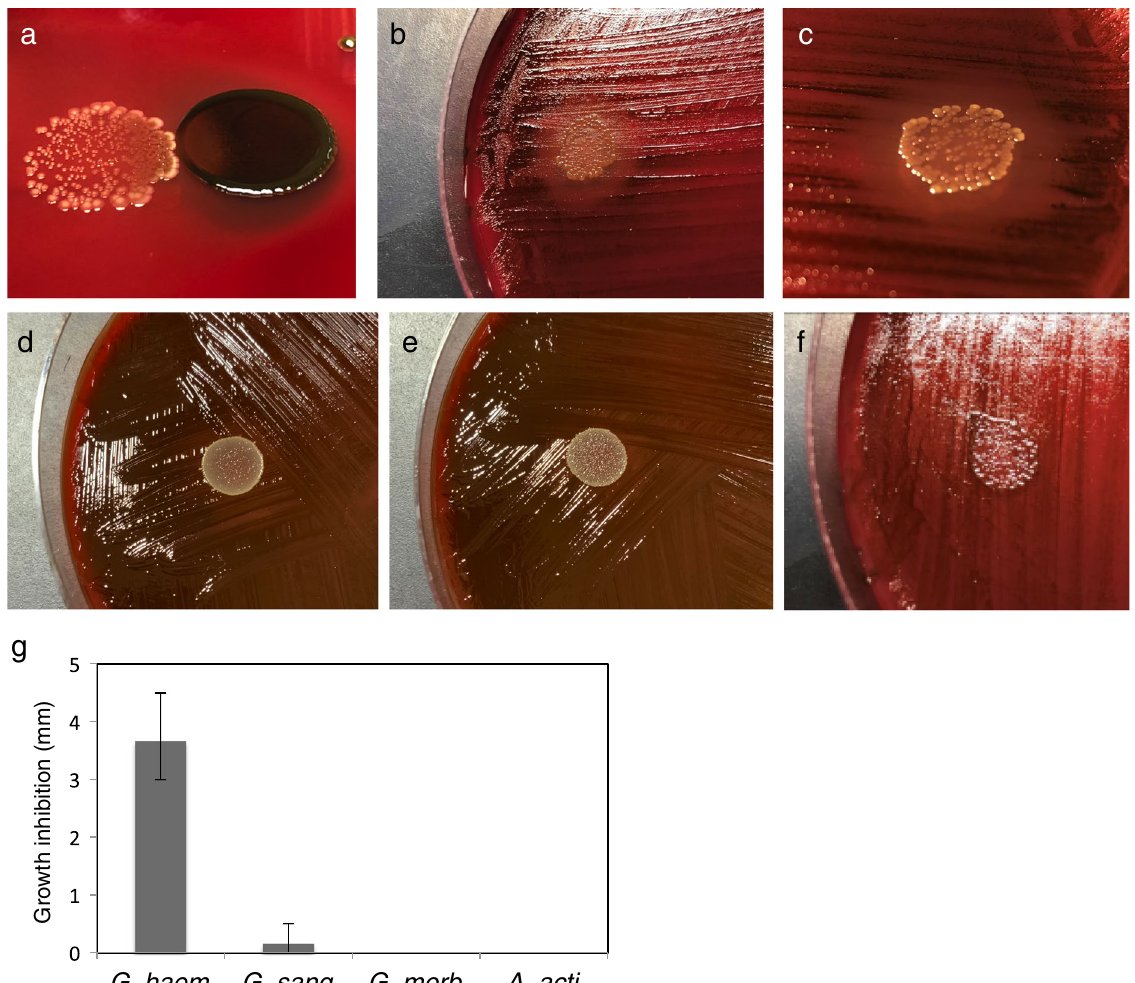
Figure 3. Effect of Gemella species on the growth of P. gingivalis. (a) Effect of G. haemolysans on the growth of P. gingivalis . Cultures of G. haemolysans and P. gingivalis were spotted adjacent to each other on a blood agar plate and incubated at 37 °C under anaerobic conditions. The white and black colored colonies indicate G. haemolysans and P. gingivalis , respectively. (b–f) Cultures of G. haemolysans (b) , G. sanguinis (d) , G. morbillorum (e) and A. actinomycetemcomitans (f) were each spotted on an agar plate spread with P. gingivalis and plates were incubated at 37 °C under anaerobic conditions. (c) The zoom image of (b) from another angle. (g) Quantification of the growth inhibition zone of P. gingivalis caused by G. haemolysans (G. haem), G. sanguinis (G. sang), G. morbillorum (G. morb), A. actinomycetemcomitans (A. acti) . Error bars show the mean ± SD. All results are representative of data generated in at least three independent